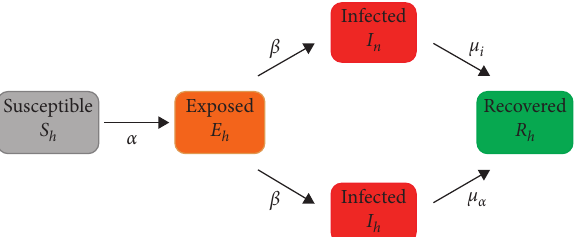
Figure 3: Diagram of the SEIR model adopted for simulating the COVID-19 infection. The infection type included symptomatic and asymptomatic